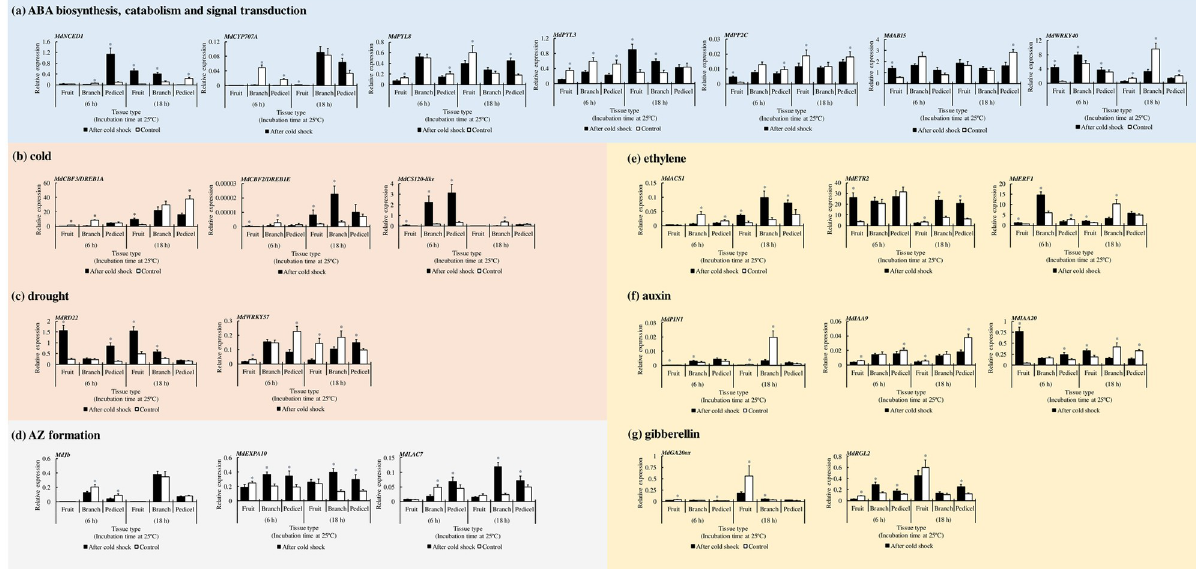
Fig 3. Spatial expression patterns of target genes involved in hormone metabolism and stress response in cold-stressed apple subunit consisting of fruit, branch, and pedicel. (a) abscisic acid (ABA) hormone biosynthesis, catabolism, and signal transduction; (b) Cold stress; (c) Drought stress; (d) Abscission-zone (AZ) formation; (e) Ethylene; (f) Auxin; (g) Gibberellin. MDP0000336547 was used as reference gene. Data are mean ± standard error (6 � n � 8). � indicate significant difference in relative expression between cold treatment and control at p < 0.05 by Student’s t -test.